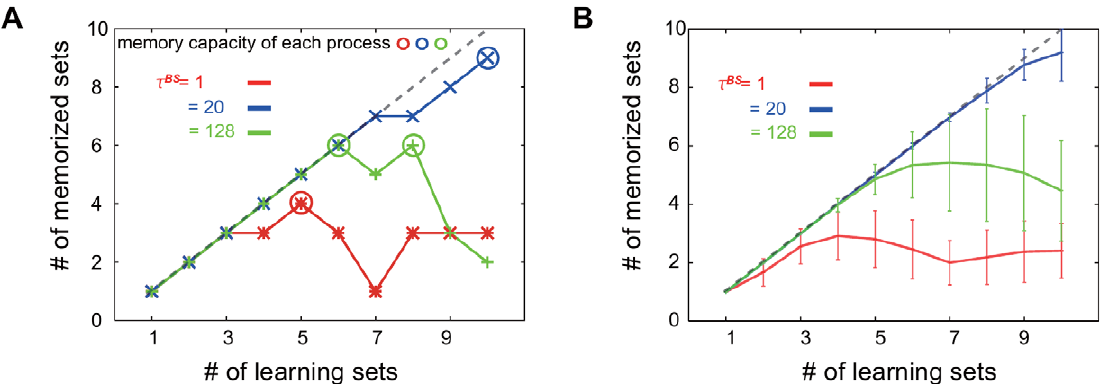
Figure 3. The number of memories through the learning process. The number of memorized sets at each learning step is plotted for three different values of t BS , by fixing t FS at 64. Red, green, and blue lines represent the number of memorized sets for t BS ~ 1 (identical to that t NA ), t BS ~ 20 (maximum memory capacity), and t BS ~ 128 , (larger than at t FS ), respectively. Dotted line represents the maximum possible number of memorized sets, i.e., the number of all learned I/O relations. A) Number of memorized sets at a single learning process. Memory capacity at each value of t BS is defined by the maximum number of memorized sets in the learning process, as shown by colored circles. B) Number of memorized sets averaged over learning processes. The number of learned sets is calculated by averaging over 100 learning processes for each value of t BS . Error bars indicate the standard deviations.